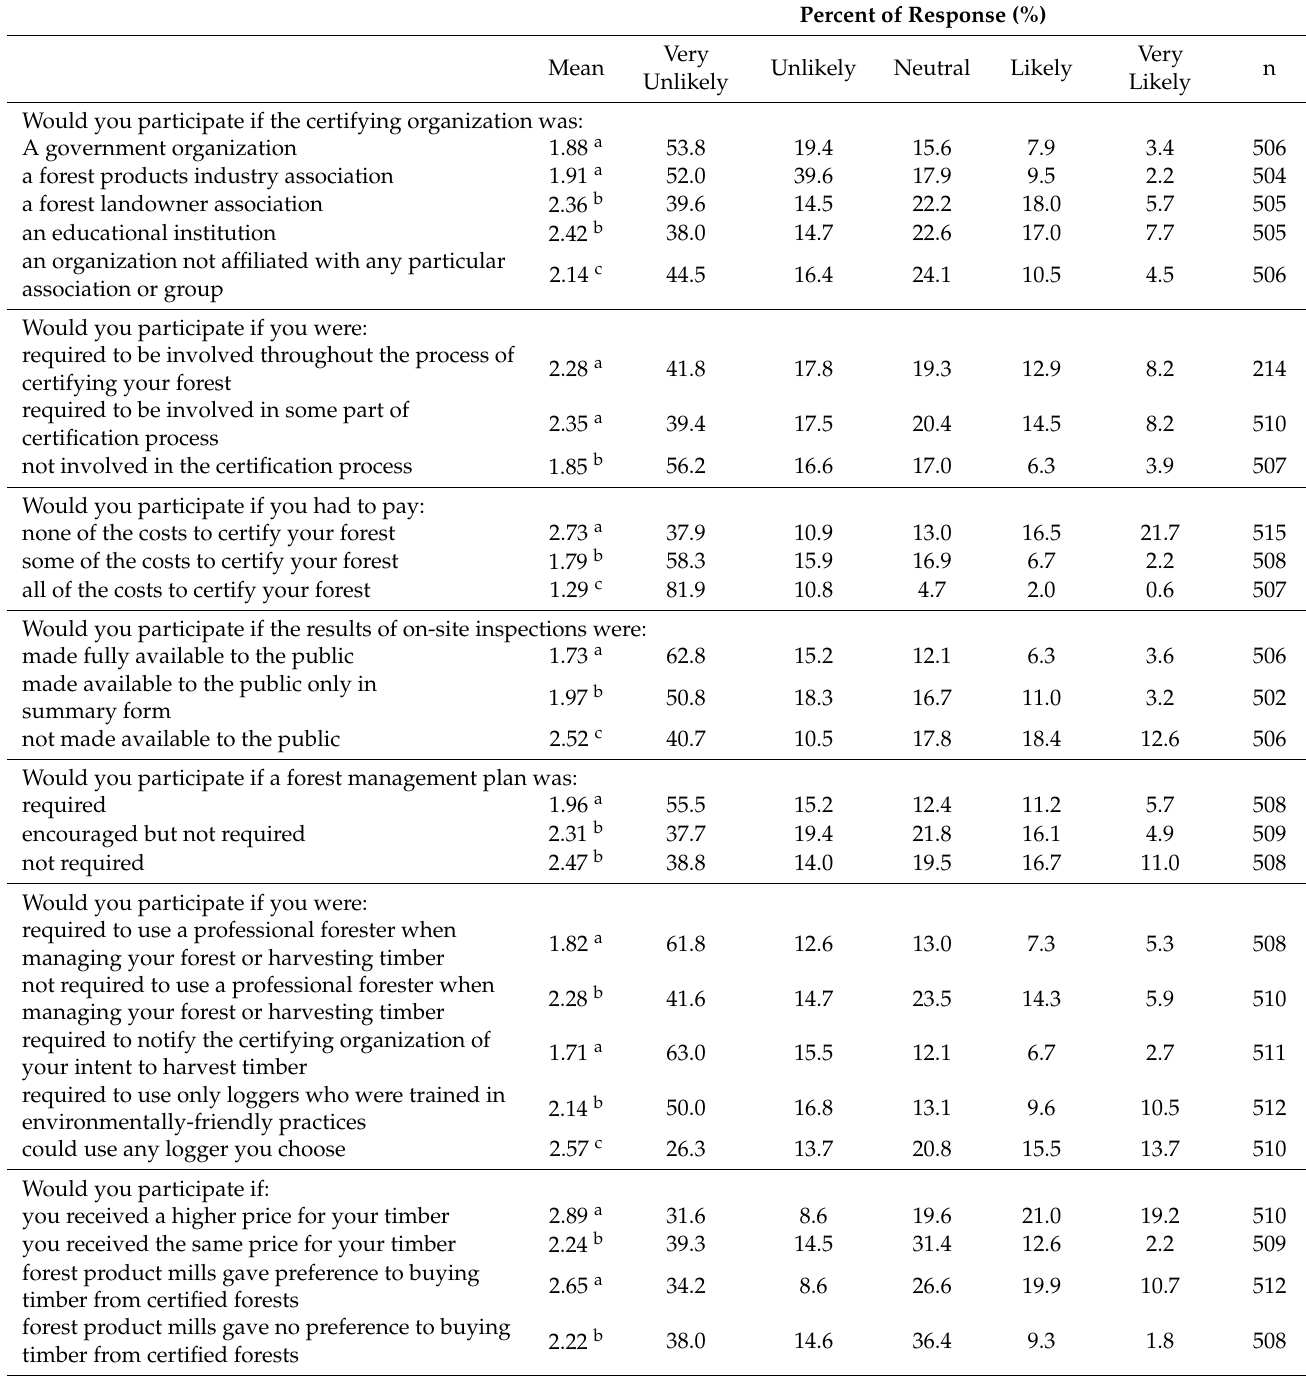
Table 4. Landowners’ willingness to participate in a forest certification program under different program